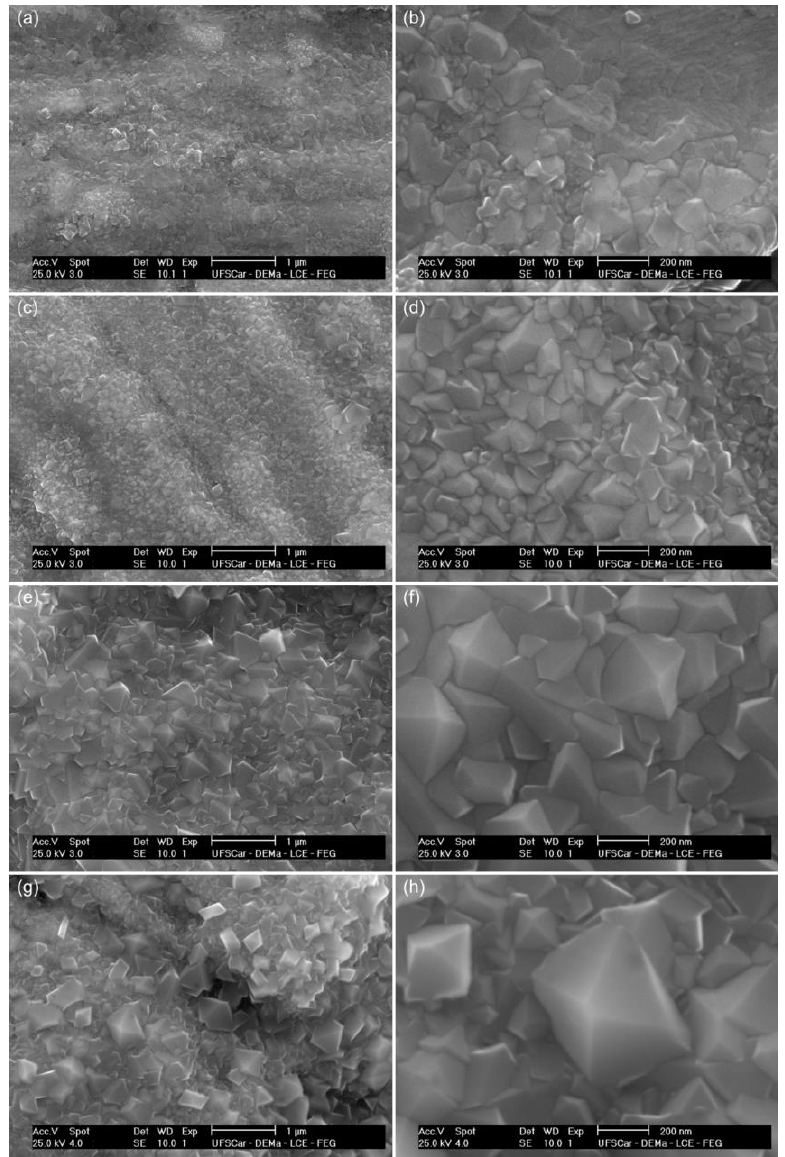
Figure 11. SEM micrographs of the Ni-based alloy after the oxidation test: ( a , b ) 660 °C; ( c , d ) 740 °C; ( e , f ) 860 °C; and ( g,h ) 900 °C.